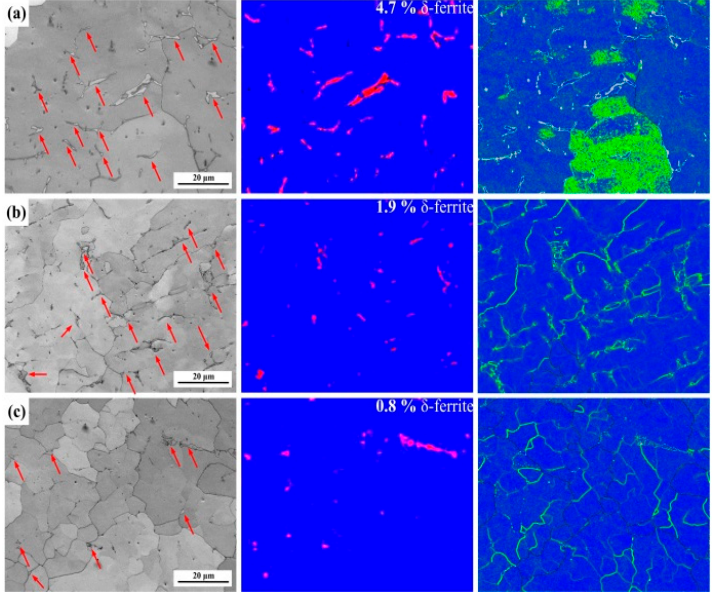
Figure 14. Contrast maps, phase distribution maps, and KAMs of 1670-8 at different places: ( a ) top, ( b ) middle, and ( c ) bottom.